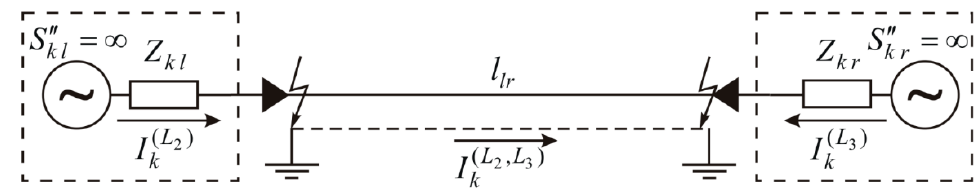
Figure 3. Single-line calculation diagram with two points at which line-to-earth faults occur simul- taneously.